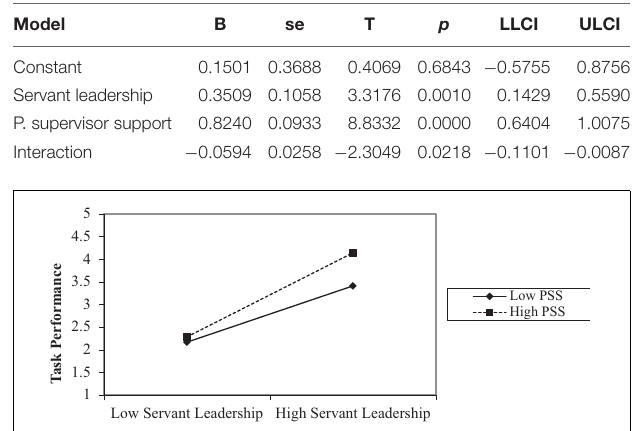
FIGURE 2 | SL × PSS = Task performance.